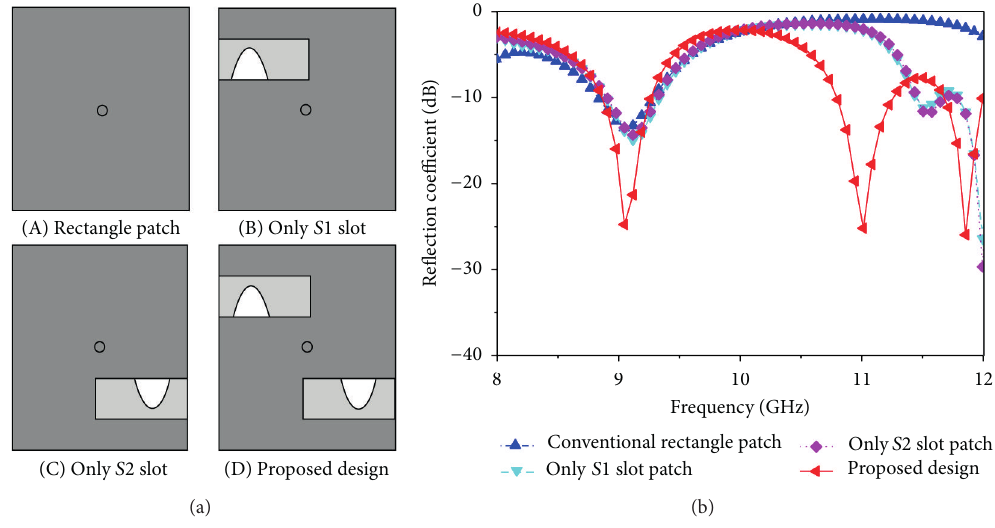
Figure 2: (a) Proposed antenna design evolution and (b) simulated reflection coefficient for different patch shapes.